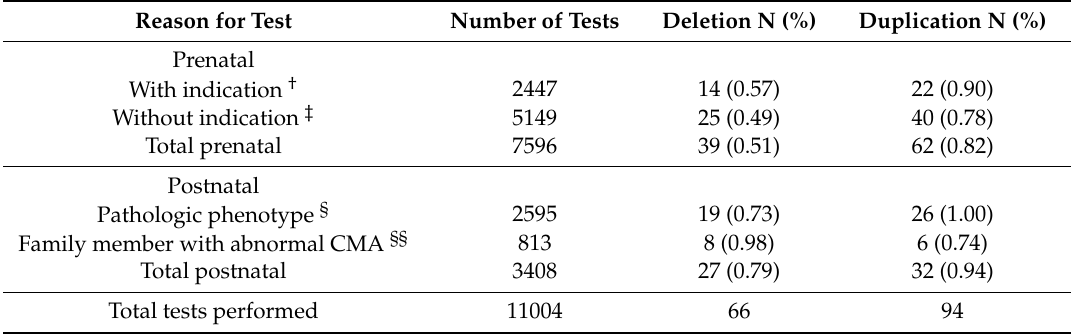
Table 1. The prevalence of deletions and duplications involving the 15q11.2 BP1-BP2